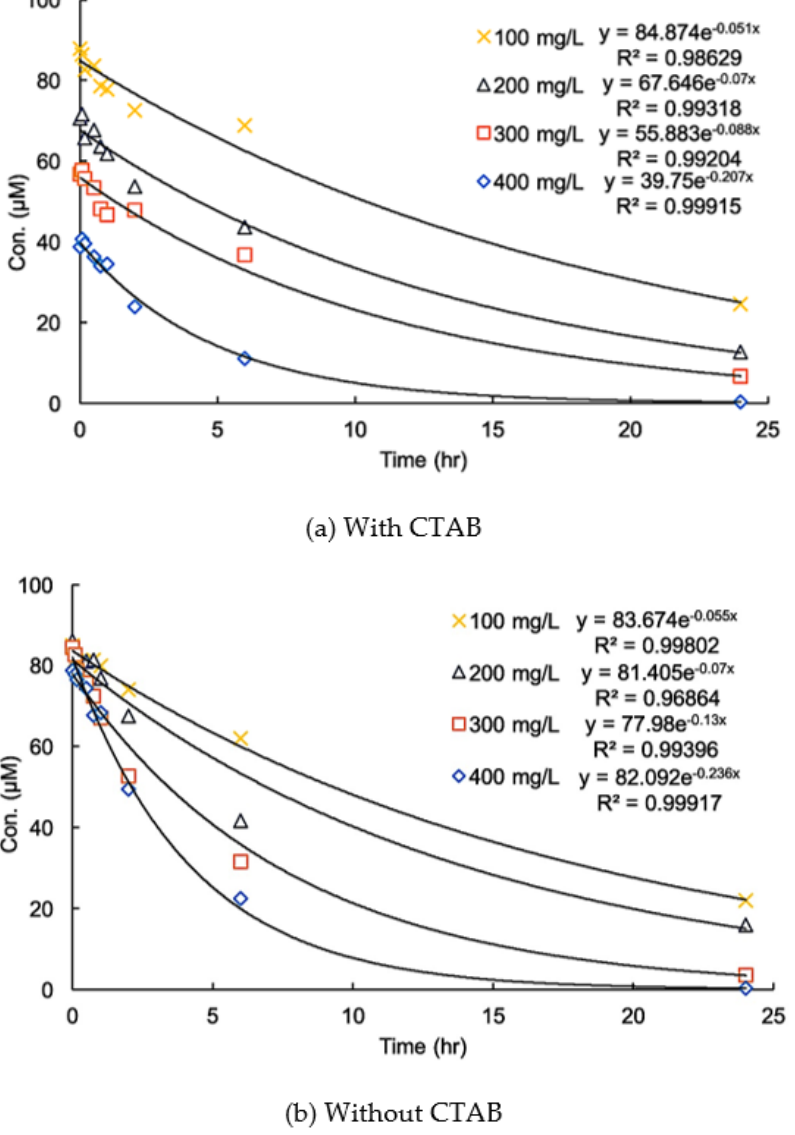
Figure 5. Effect of CTAB on the kinetics of the degradation of diclofenac (DIC) with different dosages of MnO 2 at pH 5.0 (a) with CTAB and (b) without CTAB (initial DIC conc. = 100 µM, (CTAB) = 100 µM, T = 25 °C).